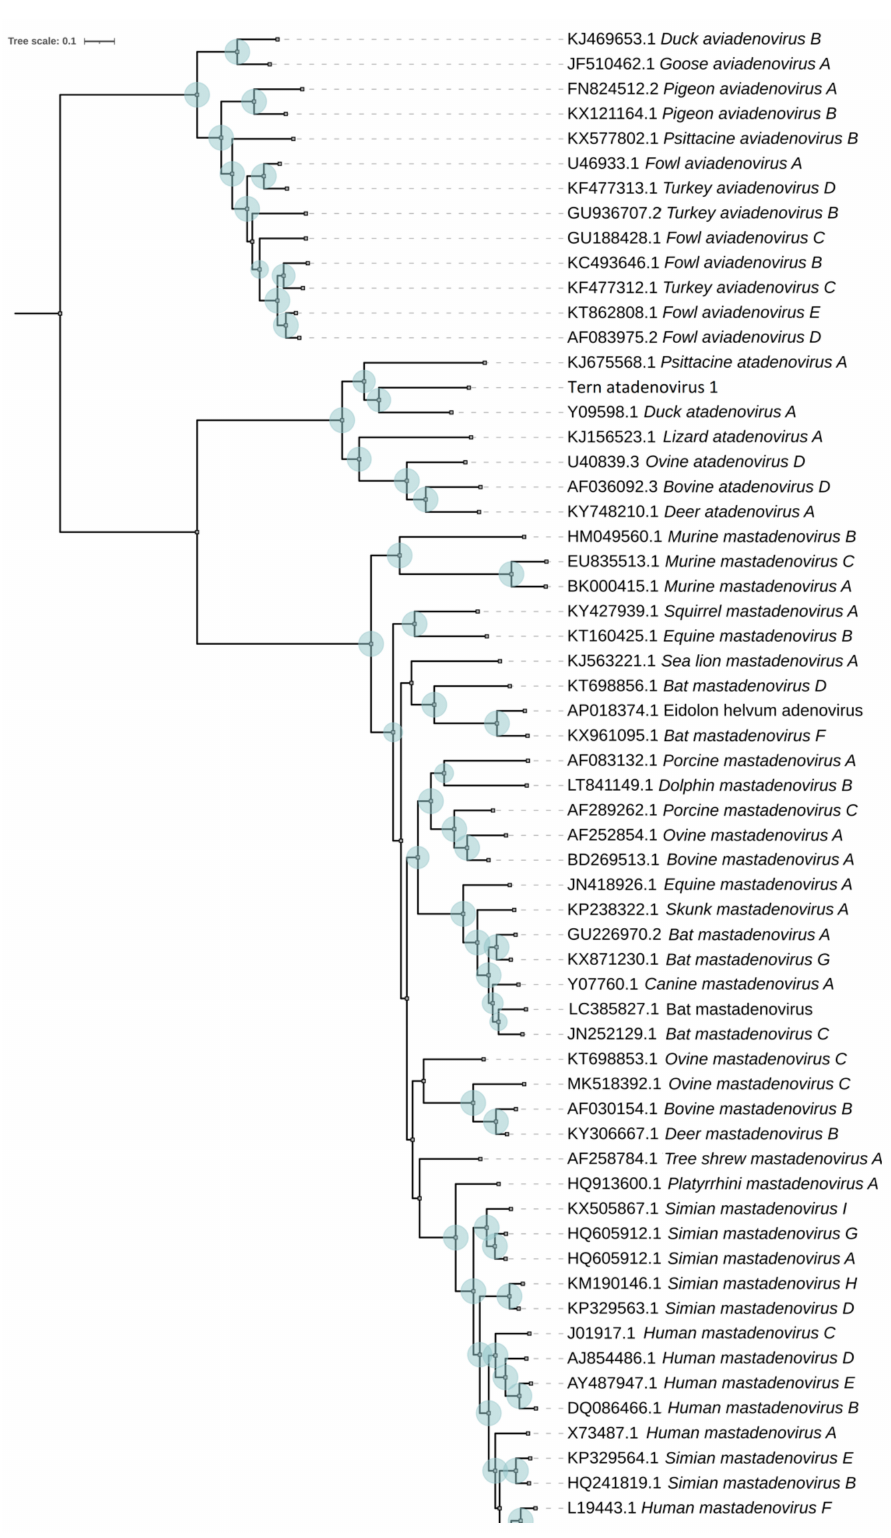
Figure 3. Maximum likelihood phylogenetic tree based on concatenated amino acid sequences of the 12 core proteins of 63 representatives of various species of the Adenoviridae family after 100 bootstrap replicates. Bootstrap values higher than 70 are marked next to the respective nodes (blue circles) showing a robust phylogenetic